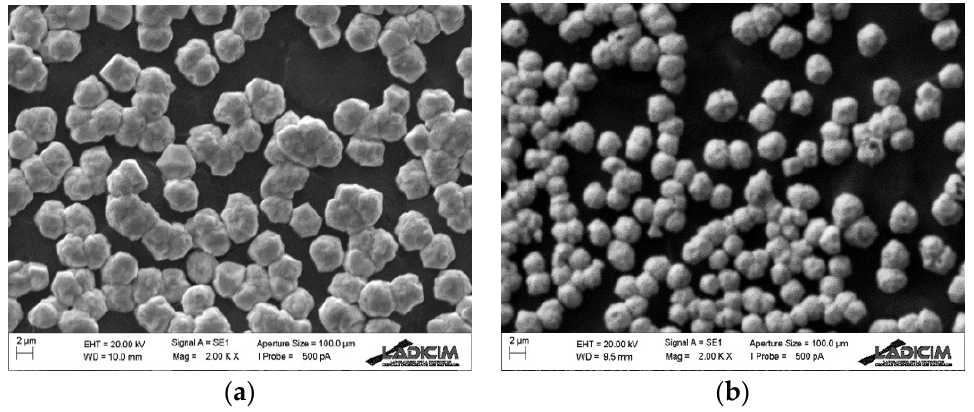
Figure 3. SEM image of copper and copper oxide-based electrodes: ( a ) copper-based electrode; ( b ) copper oxide electrode.